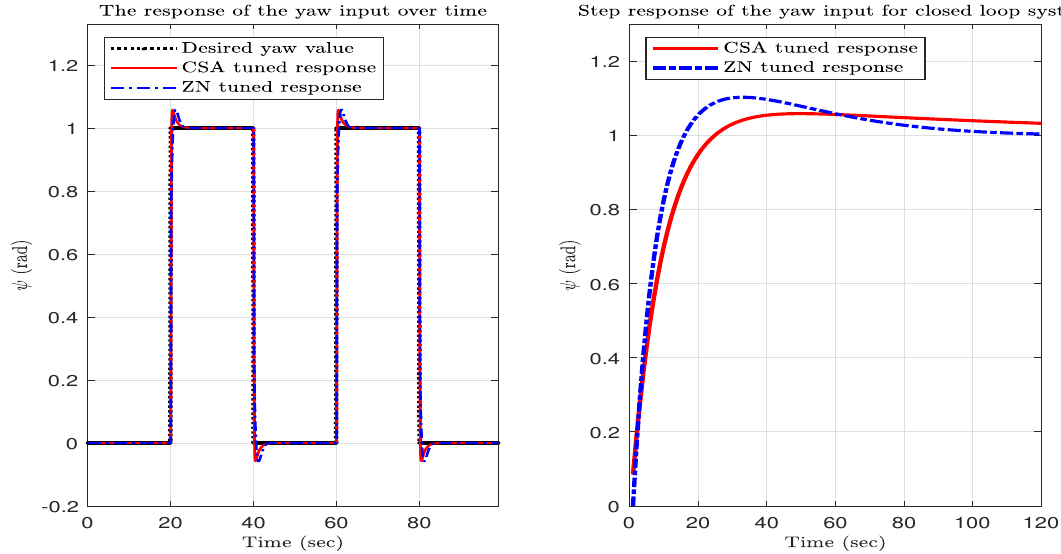
Figure 17. Simulated output responses of the yaw input of a quadcopter using CSA and ZN